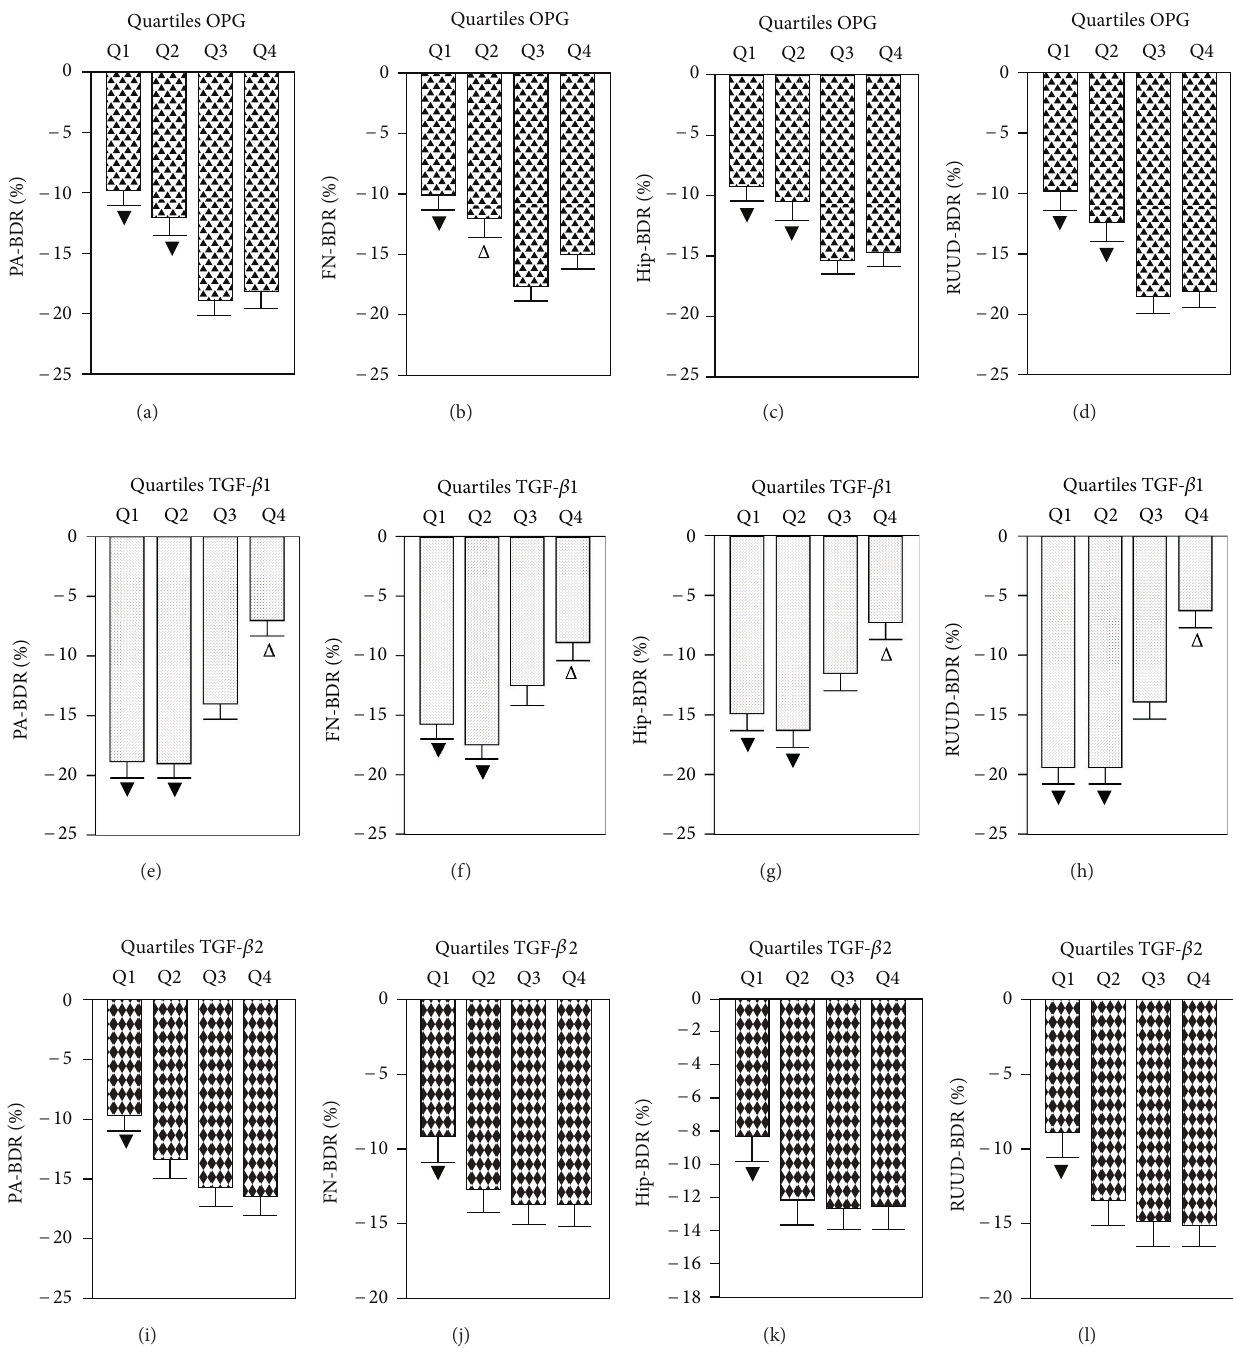
Figure2:BDRsatdifferentskeletalsitesinnativeChinesewomendisplayedbyquartilesofserumsOPG,TGF- 𝛽 1,andTGF- 𝛽 2concentrations. OPG: osteoprotegerin, TGF- 𝛽 : transforming growth factor-beta, Q1: first quartile, Q2: second quartile, Q3: third quartile, Q4: fourth